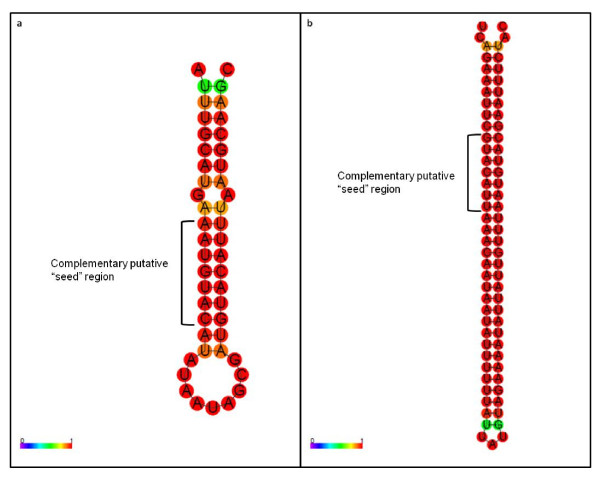
Structure of the two candidate precursor miRNAs in P. tetraurelia. a) candidate pre-miRNA (location in macronuclear genome: scaffold_567:869-915); b) candidate pre-miRNA (this is a portion of an EST [cDNA clone LK0ADA28YP05; collected at conjugation (beginning of meiosis)] that can be only partially mapped to the 3' end region of three 60S ribosomal protein-coding gene L1 that are located in scaffold_161: 34738-35490; scaffold_253: 730-1589; and scaffold_151: 51790-52544). Color scale displays base-pairs probability.